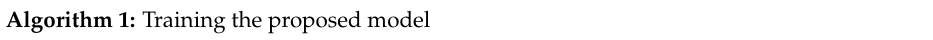
Algorithm 1: Training the proposed model